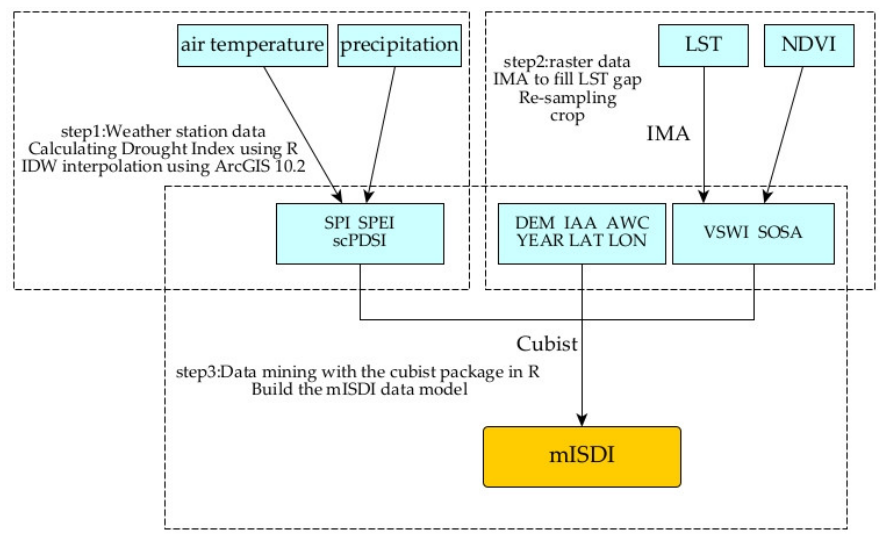
Figure 3. The mISDI flow chart. Independent variables were defined in the main text and in Table